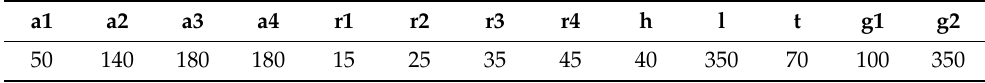
Figure 1. Schematic of the circular-patched Yagi-like THz MIMO antenna structures. ( a ) Three-dimensional view of the antenna, with graphene as the conducting material with Port notation. ( b ) Front side and backside view of the antenna. ( c ) A comprehensive view of the patched Yagi-like structure, with dimensions. ( d ) Schematic of the single antenna with dimensions. Table 1. Dimensions of the 2 × 2 MIMO antenna structure (all dimensions in µ